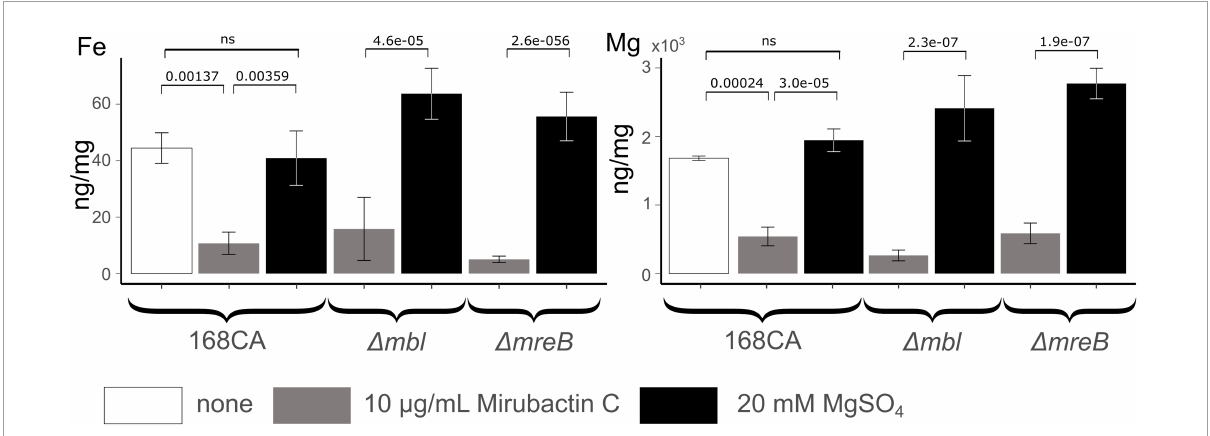
FIGURE5 Cellular Fe and Mg content of Bacillus subtilis 168CA and (cid:49) mbl , (cid:49) mreB, mutant cells, as determined by ICP-MS, after culture in PAB medium with/without supplementation with 20 mM MgSO 4 or 10 µ g/ml mirubactin C. P -values are given for selected conditions which were calculated using the pairwise t -test function of the ggpubr package in R.